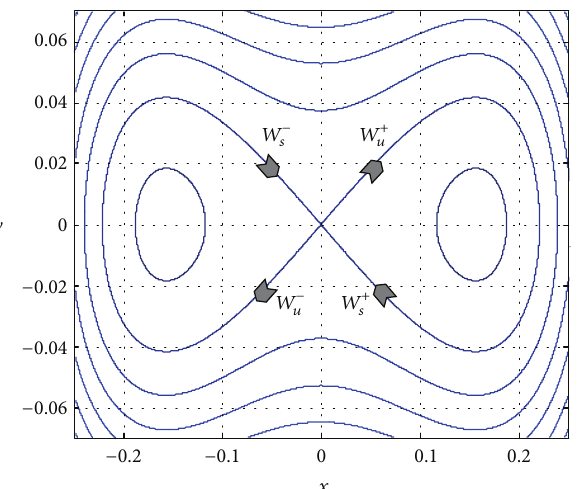
Figure 4: Homoclinic bifurcation curve in the ( 𝑓 𝑝 − 𝜔 ) plane.